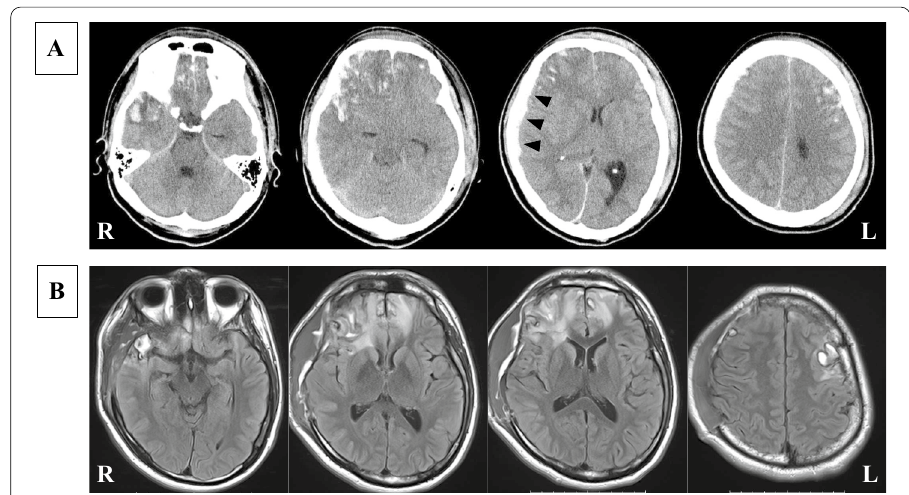
Fig. 1 A Head CT scan on the day of injury showed multiple brain contusions (salt and paper appearance) in the right frontal and temporal lobes and left frontal lobe along with a right acute subdural hematoma (arrow heads). B FLAIR MR imaging 23 days after the injury showed multiple high-intensity regions in the right frontal and temporal lobes and left frontal lobe along with high-intensity areas in the white matter surrounding the brain